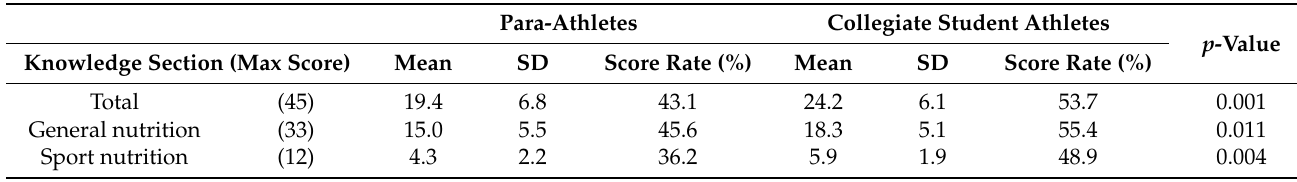
Table 4. The score of nutrition knowledge questionnaire obtained from para-athletes and collegiate student athletes.